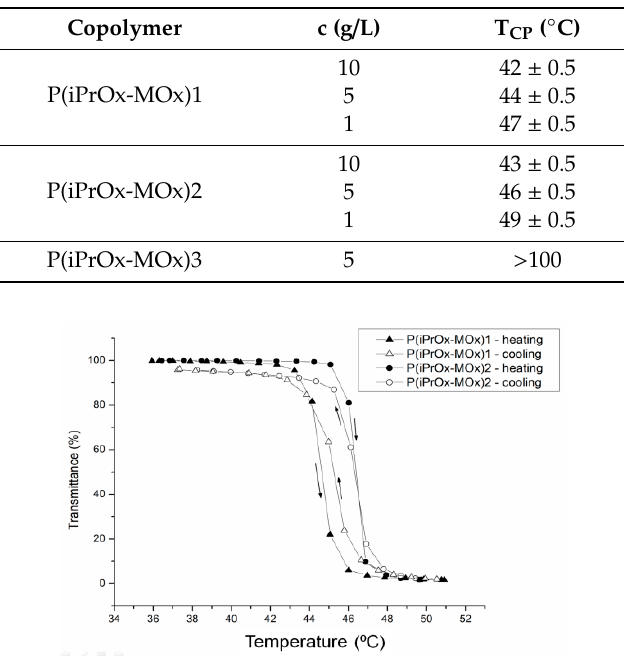
Figure 3. Transmittance-temperature dependence during heating (filled signs) and cooling (empty signs) of aqueous solutions of copolymers (c = 5 g/L). signs) of aqueous solutions of copolymers (c = 5 g / Table 2. T CP values of copolymers at different concentrations in water .